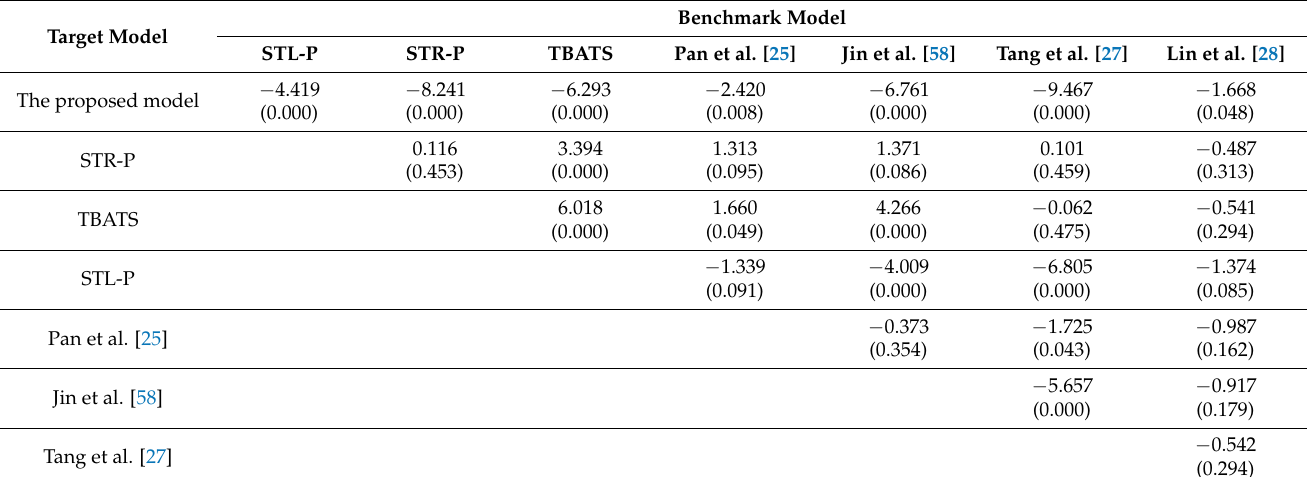
Table 9. Results of the DM test in